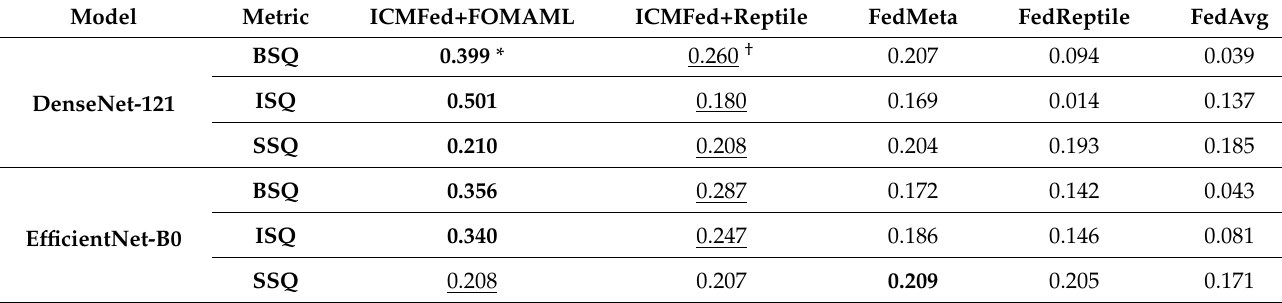
Table 5. Evaluation result of service-quality